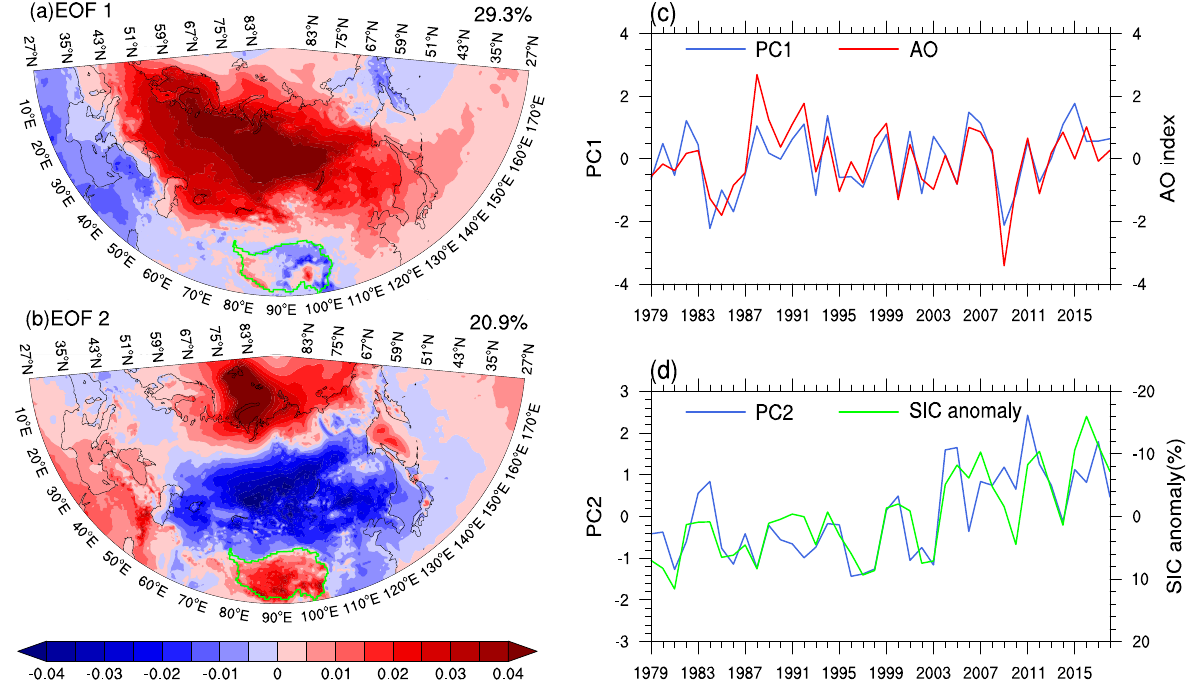
Fig. 2 The two leading modes of winter SAT anomalies (27° – 90°N, 0° – 180°E). a, b EOF1 and EOF2 of winter mean SAT in ERA5. c, d Standardized PC time series (blue lines) and AO index (red line), SIC anomaly (green line, unit: %) in the BKS (axis